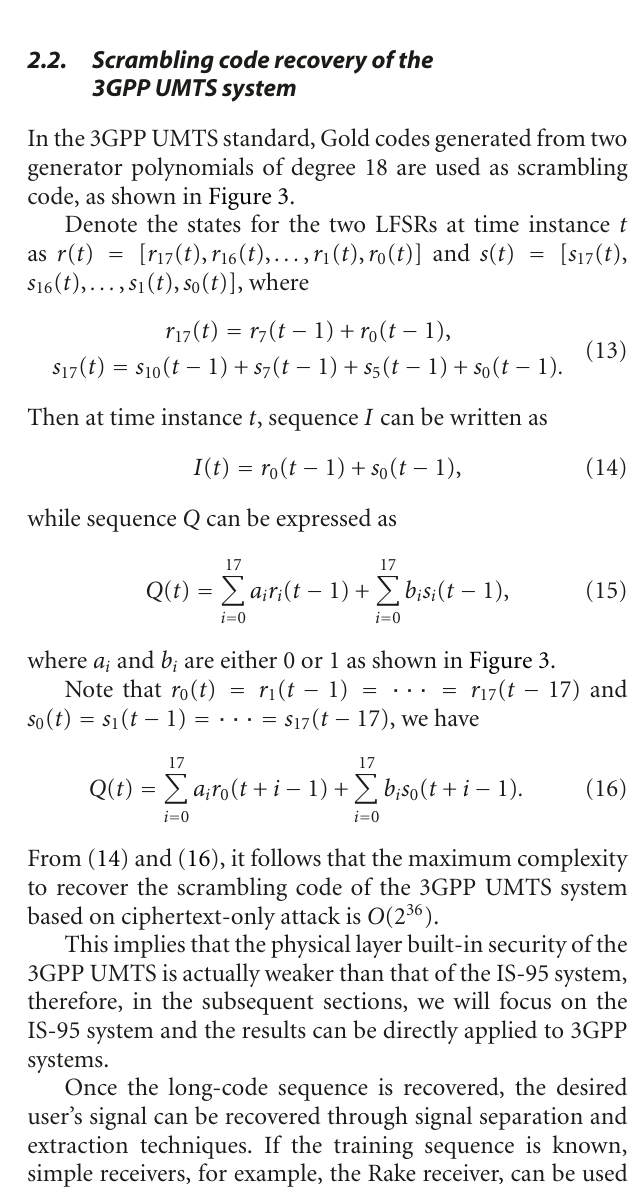
Figure 1: Block diagram of a long-code DS-CDMA system.